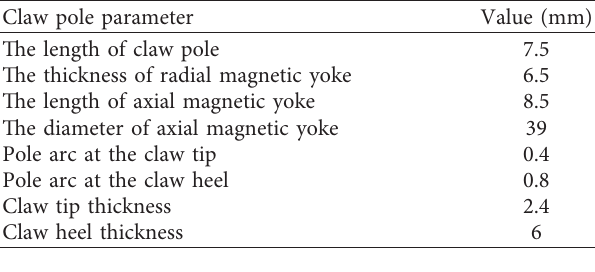
Table 3: Structural dimensions of the EER.